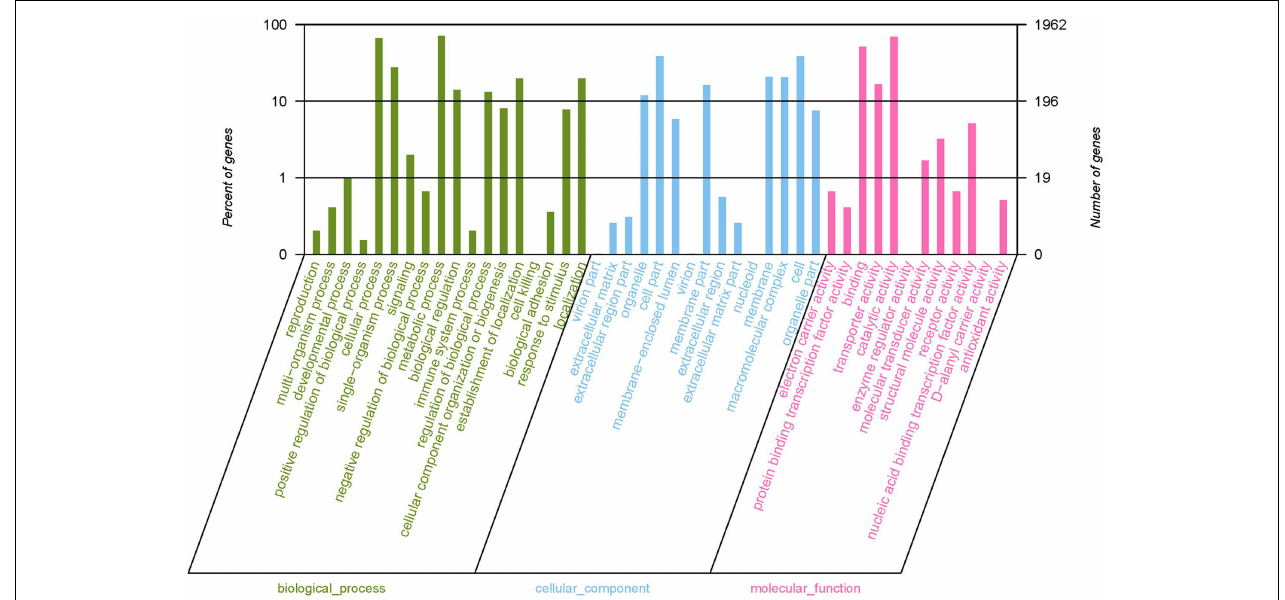
GO assignments. The vertical scale on the right side indicated the number of each sub-categories of GO terms. Because some genes were assigned to more than one GO term, the sum of the percentage of all sub-categories of GO terms was more than one and the total number of GO terms was bigger than the total number of the unique